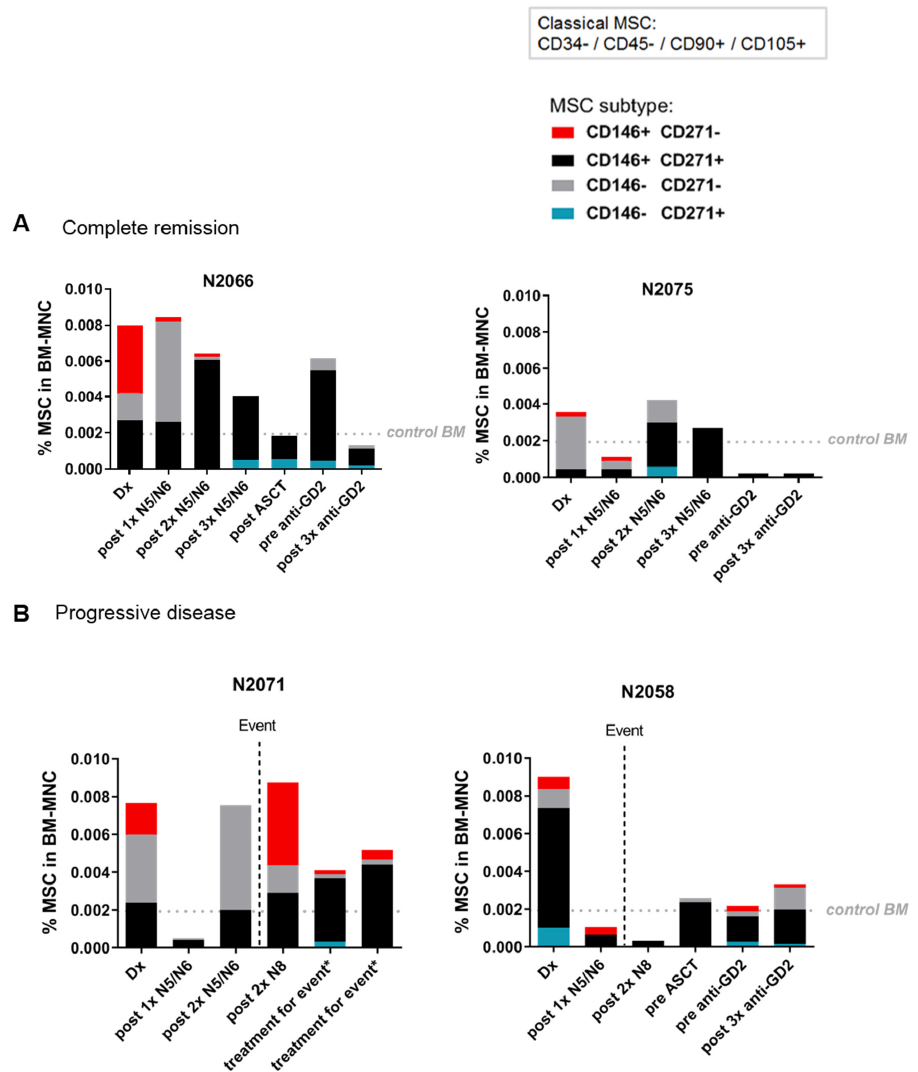
Figure 5. The MSC subtype disappears during treatment and is detected again at relapse. MSC